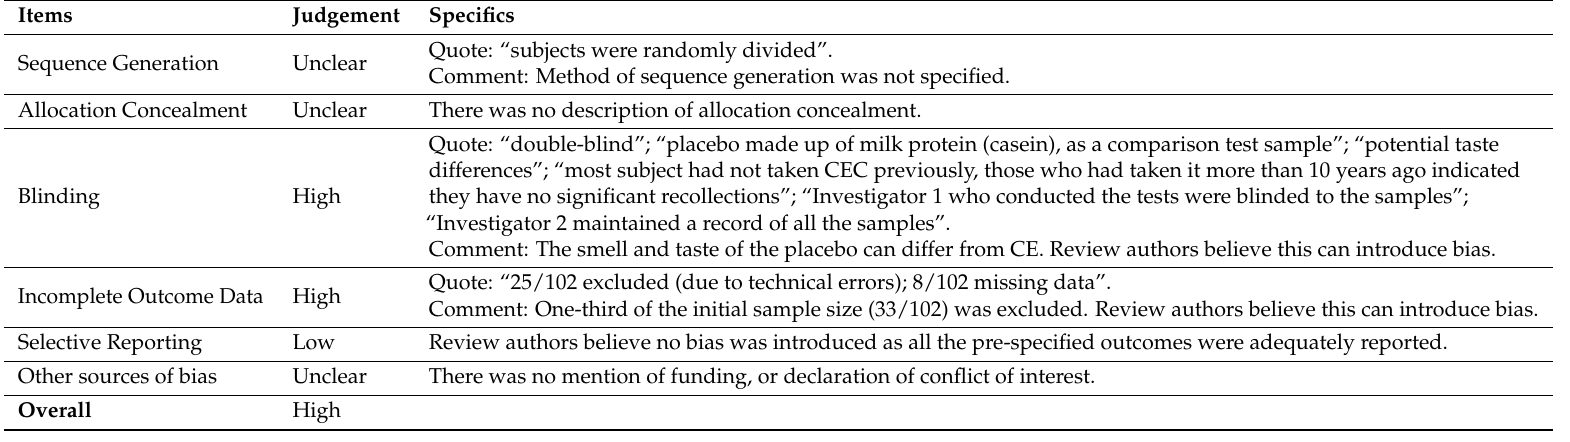
Table A3. Risk of bias assessment of Azhar 2008, [15].